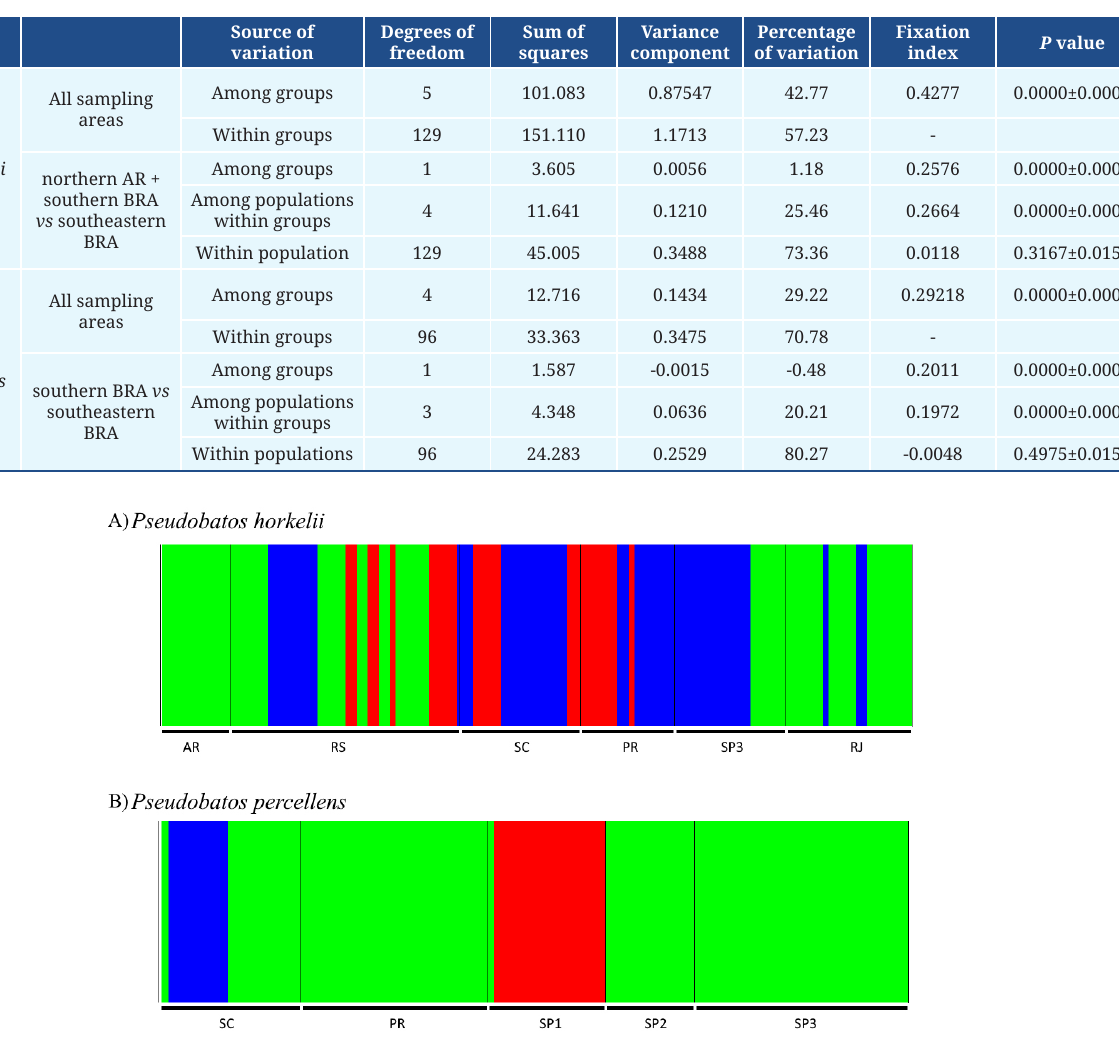
FIGURE 2 | Graph of the Bayesian analysis of population structure of mtCR for A. Pseudobatos horkelii and B. Pseudobatos percellens. Samples from northern Argentina (AR), Torrinha/RS (RS), Florianópolis/SC (SC), Pontal do Paraná/PR (PR), Cananéia/ SP (SP1), Mongaguá/SP (SP2), Santos/SP (SP3), Rio de Janeiro/RJ(RJ).